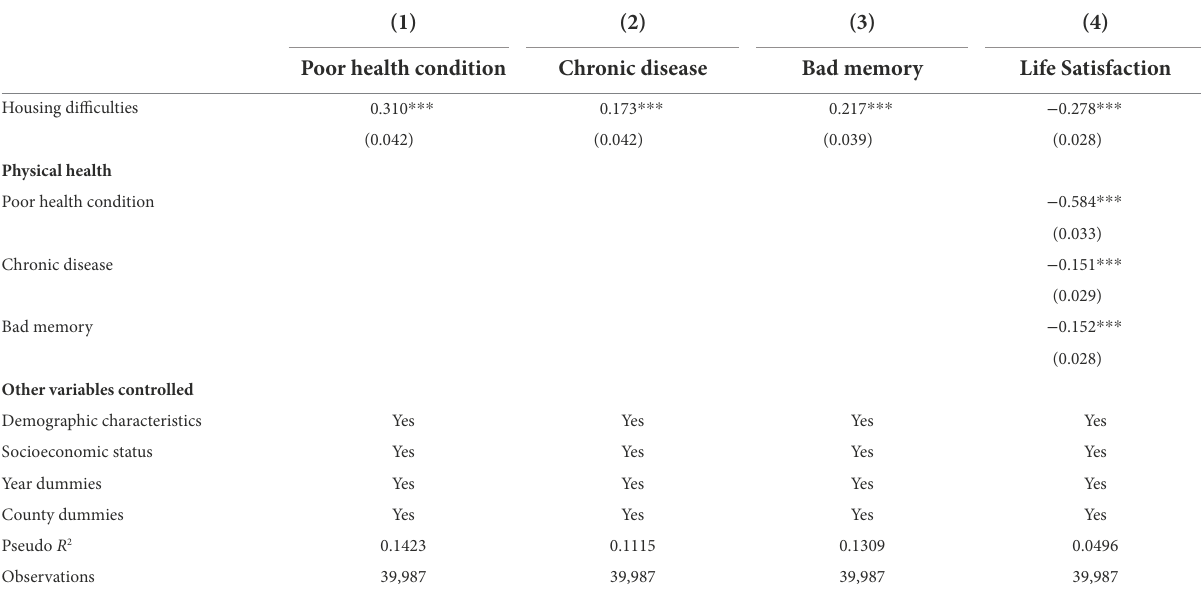
TABLE 3 Housing difficulties, physical health and life